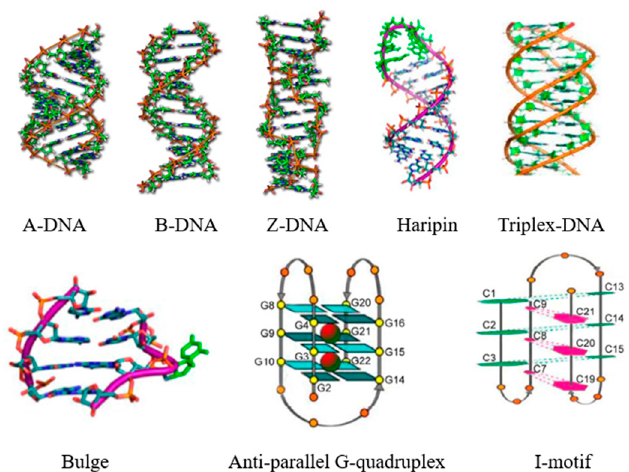
Figure 1. Different DNA forms. Reproduced with permission from the authors of [3,5]. Copyright © 2001, Royal Society of Chemistry. Copyright © 2014, Science China Press. B-DNA—DNA double helix. A-DNA—It is a right-handed double helix fairly similar to the more common B-DNA form, but with a shorter, more compact helical structure. Z-DNA—It is a left-handed double helical structure in which the helix winds to the left in a zigzag pattern.